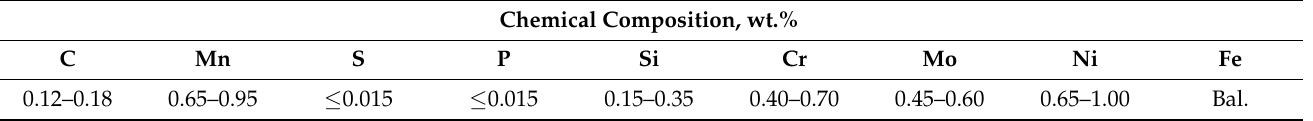
Table 1. Chemical composition of low-alloy structural steel AISI 4715 according to the manufacturer data (TimkenSteel Ltd., Canton, OH, USA). Chemical Composition,